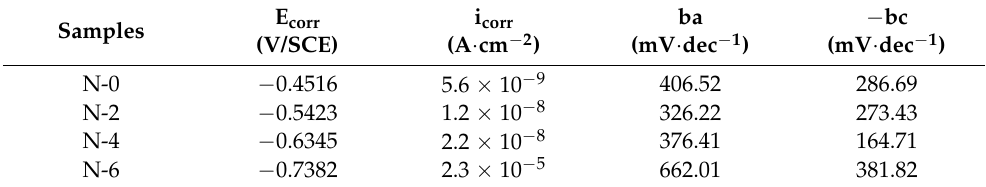
Figure 7. The potentiodynamic polarization curves of NiCoCrAlY/MSZ coatings before and after NSS test. Table 4. Corrosion potential E corr and current density i corr of all the NiCoCrAlY/MSZ coating sam- ples.